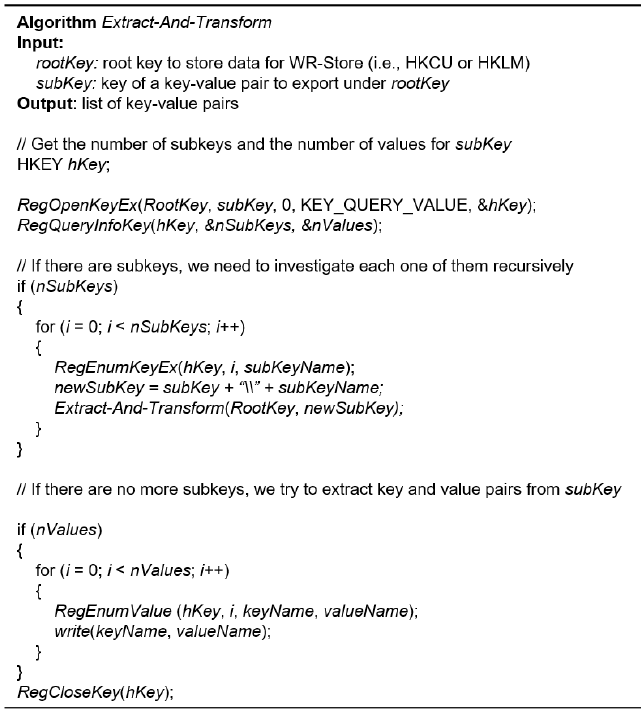
Figure 15. The algorithm of Extract-and-Transform (E-and-T) for WR-Store.